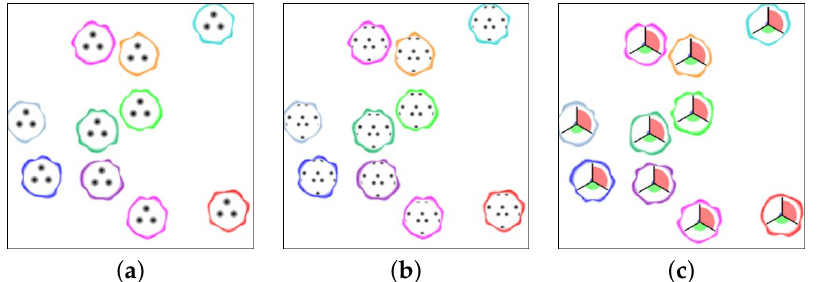
Figure 10. Examples of our texture glyph used in our user study ( a ) periodic, ( b ) non-periodic, ( c ) the baseline pie